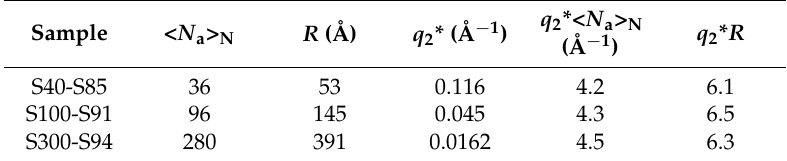
Table 2. Characteristics of the NaPSS stars in the dilute regime. < N a > N is the number average arm degree of polymerization; R , the star geometric radius obtained from the position q 1 * of the first maximum of the scattering function measured at c *; q 2 *, the position of the second maximum of the scattering function measured at c ď c